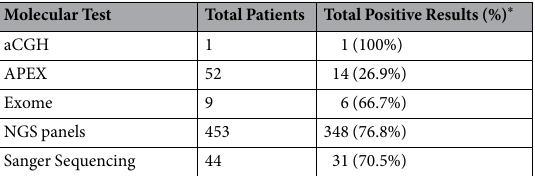
Table 1. Number of patients according to the sort of molecular test performed. The total number of patients that underwent molecular testing is 559, with positive results in 400. * Percentage based on the total number of patients who underwent molecular testing. aCGH: microarray comparative genomic hybridization; APEX: arrayed primer extension; NGS panels: next-generation sequencing gene